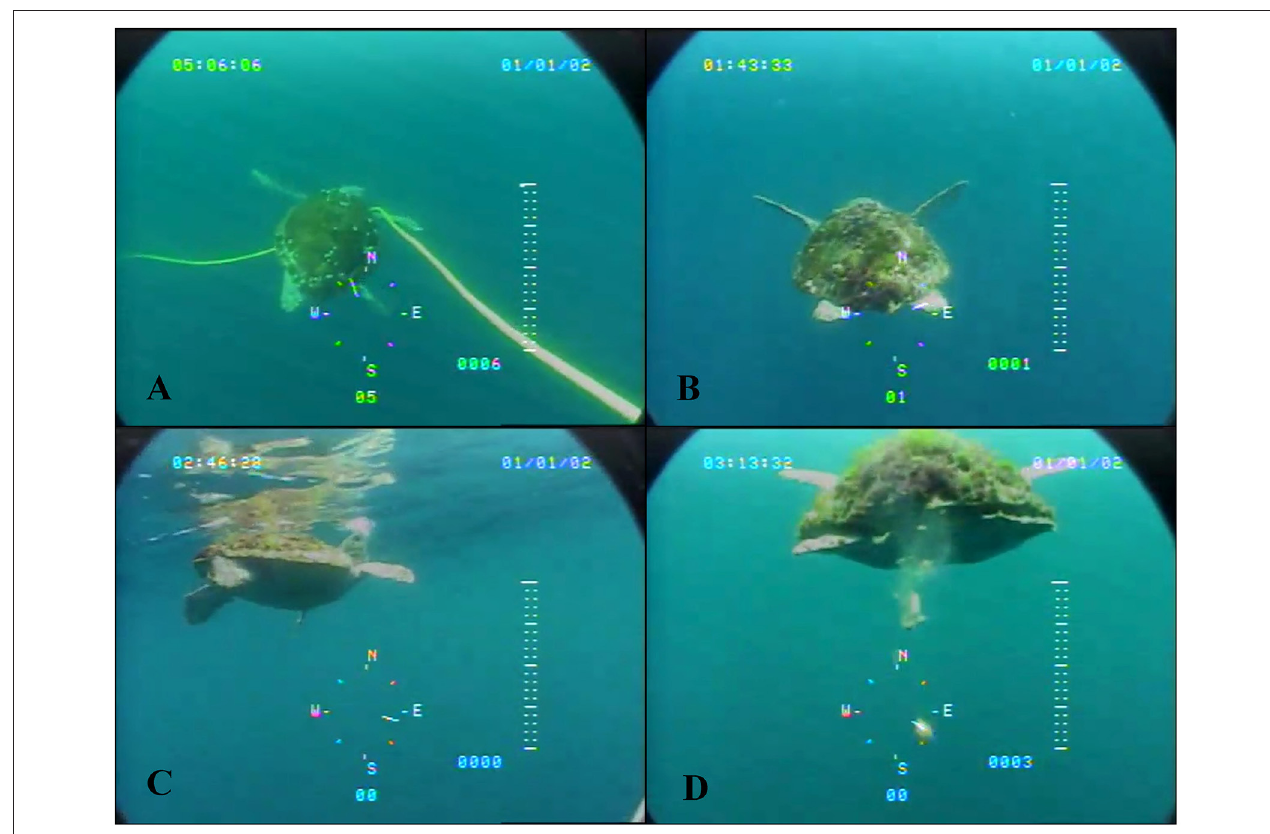
FIGURE 3 | (A) Turtle interacting with the ROV tether, briefly getting it caught between its own head and right front flipper. (B) Flipper orientation we classified as the start of a flipper beat. (C) Footage classified as a breathing event. (D) Footage classified as a defecation